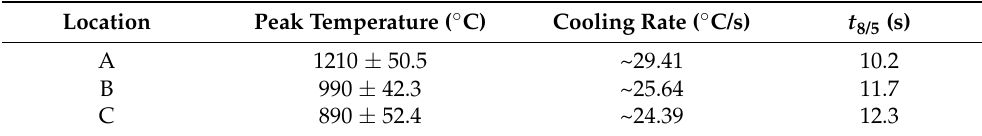
Figure 2. ( a ) Welding system, ( b ) Schematic diagram of the thermal cycle sampling point for the plate butt welding. Table 3. The thermal cycle in A, B, and C (single weld bead only).